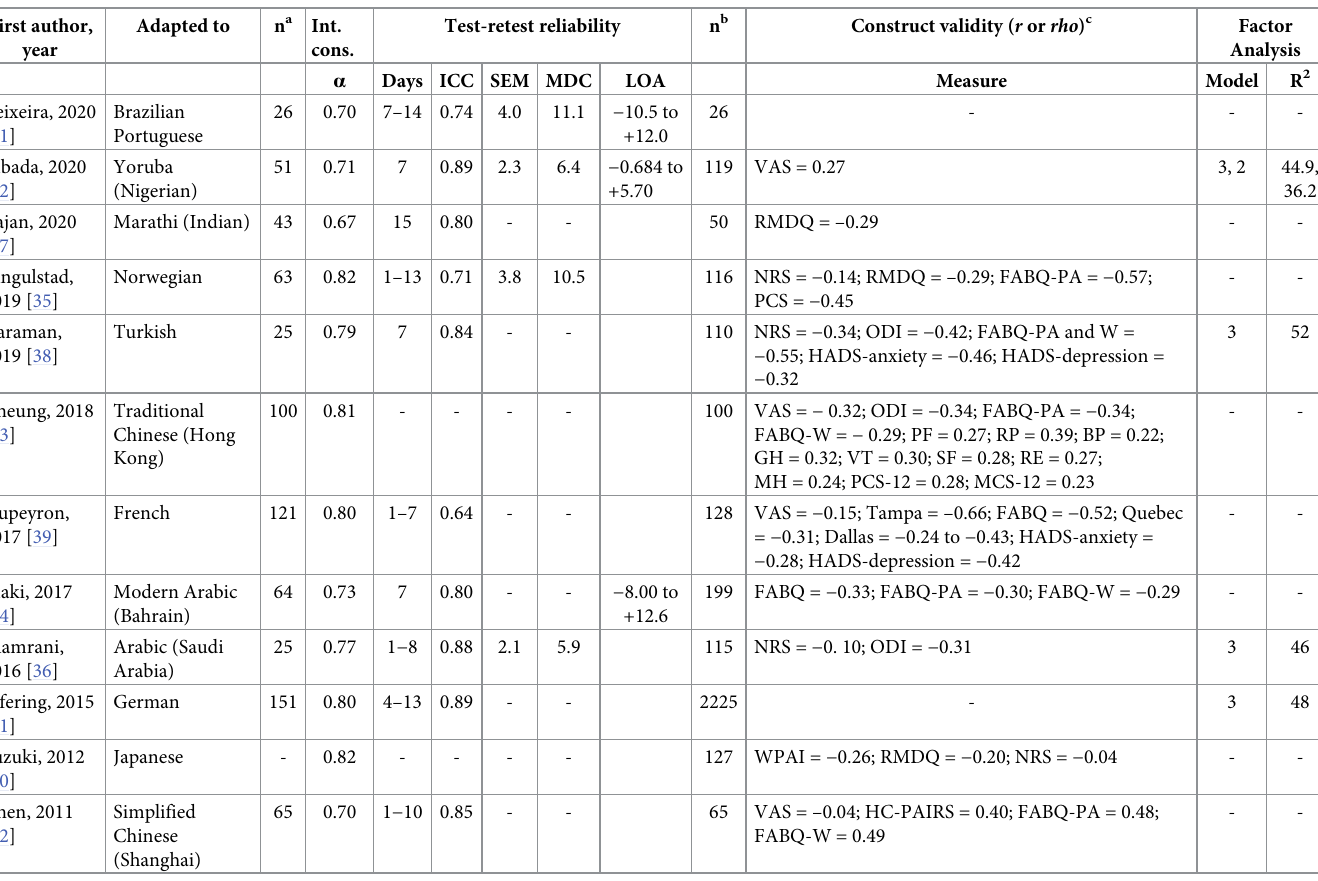
Table 6. Summary of psychometric properties of the published adapted Back Beliefs